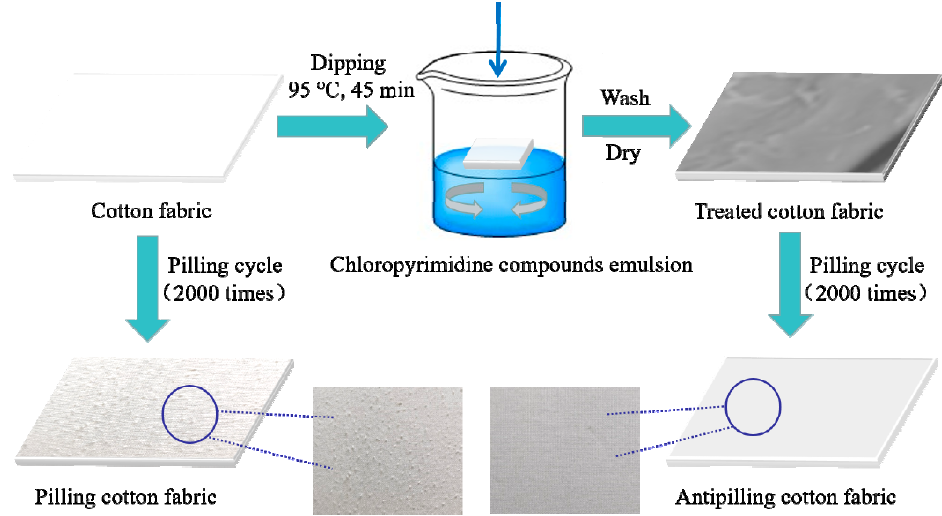
Figure 2. Schematic of the preparation process of the antipilling cotton